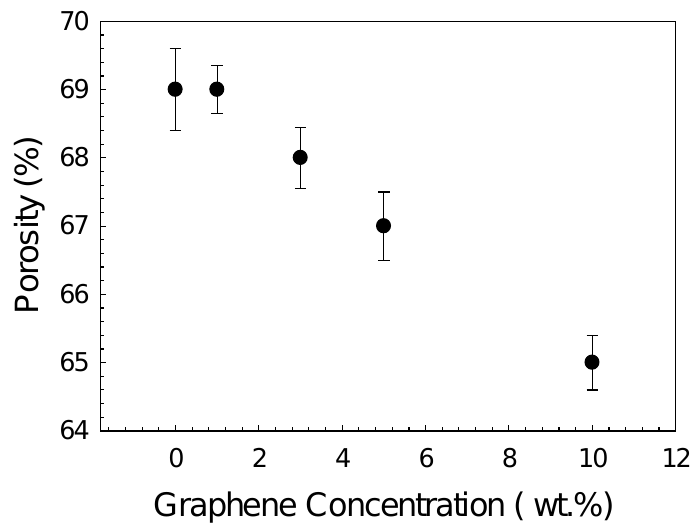
Graphene Concentration ( wt.%) Figure 4. Total porosity of the graphene-containing PCL-coated bioactive glass Figure 4. Total porosity of the graphene-containing PCL-coated bioactive glass scaffolds.